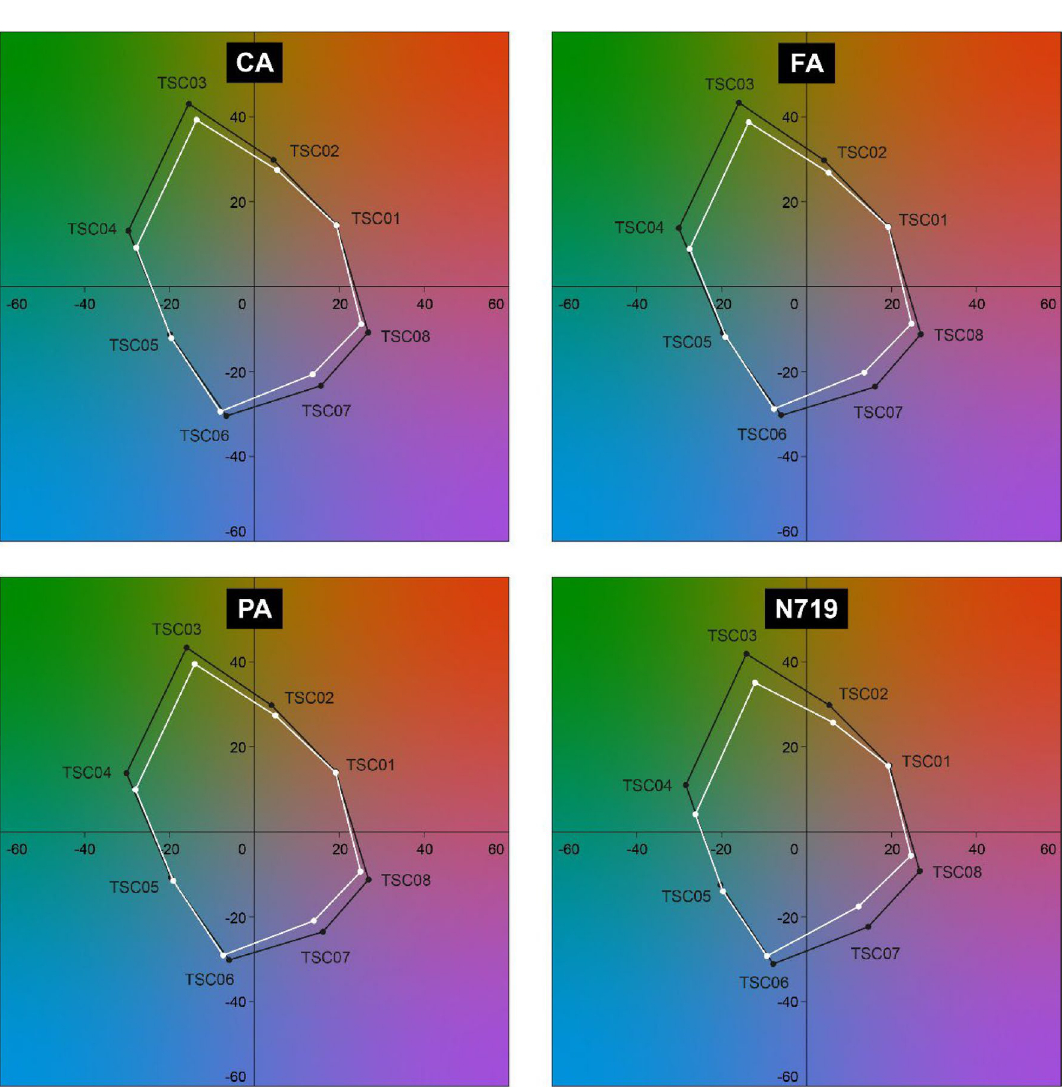
Figure 7. Color coordinates of the eight test color samples (TSC01 to TSC08) illuminated by light transmitted through the HCA cells (CA, FA, and PA) and the N719 cell (white dots) and the reference blackbody (black